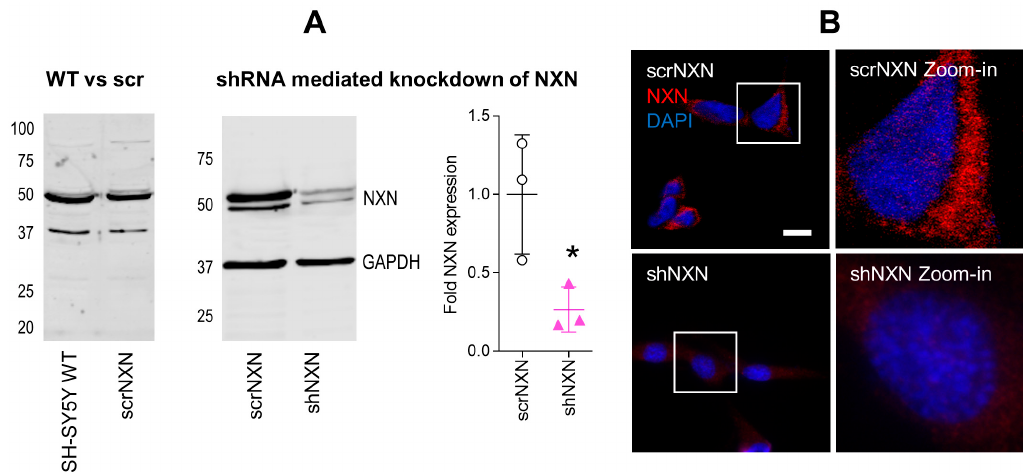
Figure 1. Expression of nucleoredoxin in NXN knockdown SH-SY5Y neuroblastoma cells. ( A ) Exemplary Western Blot and quantification of NXN (49 kDa) in wildtype SH-SY5Y human neuroblastoma cells and in stably transduced scrNXN and shNXN SH-SY5Y cells. Cells were transduced with a lentiviral vector carrying small hairpin RNAs against NXN (shNXN) or scrambled shRNA (scrNXN). GAPDH (37 kDa) was used as loading control. The data show the mean + SD of 3 experiments, and they were compared by Student’s t -test. The asterisk shows a significant result, * p < 0.05. ( B )